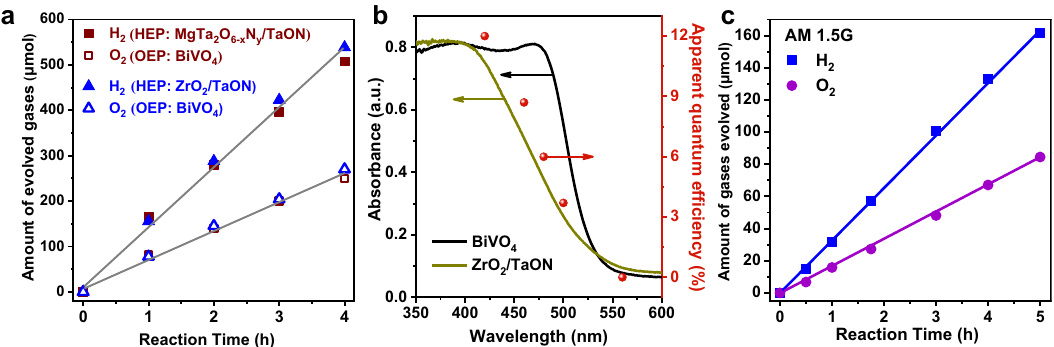
Fig. 5 Photocatalytic activity of Z-scheme OWS. a Time course of Z-scheme OWS on the optimized conditions under visible light irradiation. b Dependence curve of AQE value as a function of irradiation wavelength, and UV-Vis DRS of the HEP and OEP. c Time curve of Z-scheme OWS under illumination of the standard solar simulator (AM 1.5 G, 100 mWcm − 2 ). Reaction conditions: a 50 mg OEP, 50 mg HEP (ZrO 2 /TaON, 1.0 wt% Rh, 1.5